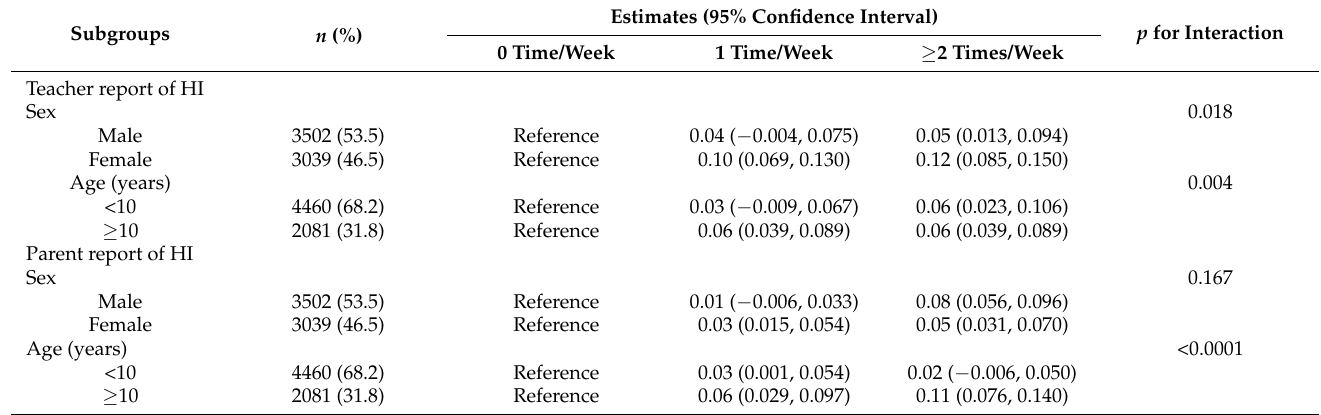
Table 4. Subgroup analysis of association between hyperactive index and SSB